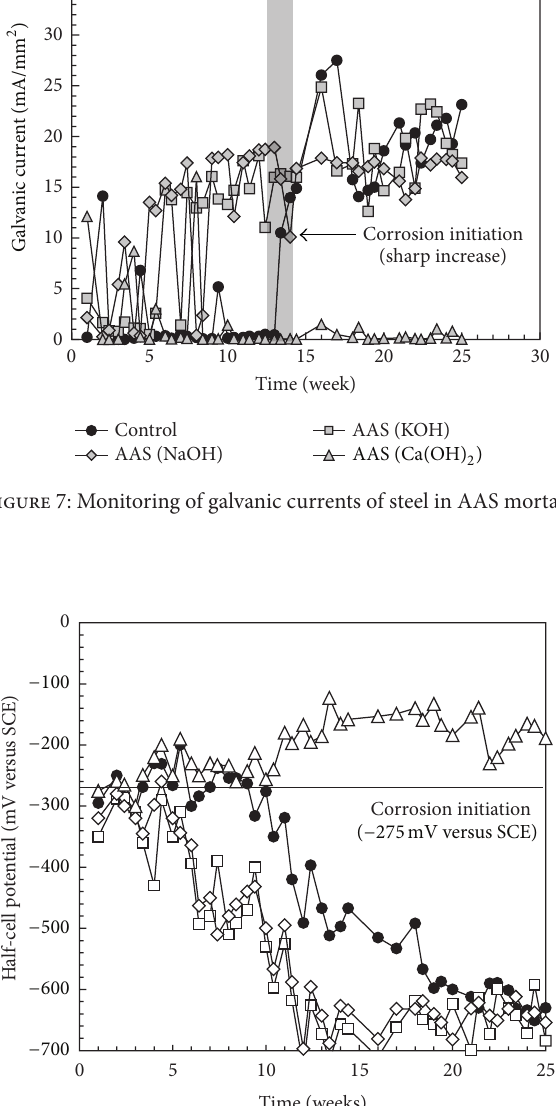
state, while the AAS containing KOH and NaOH activators indicated the corrosive state mostly from the beginning of monitoring. Again the AAS containing the Ca(OH) 2 activator showed the highest half-cell potential, indicating no corrosion formation. Substantially, it can be said that the AAS can be beneficial with the Ca(OH) 2 activator against chloride-induced corrosion, arising from increased binding of chlorides in the form of Ca(ClO) 2 and modified pore